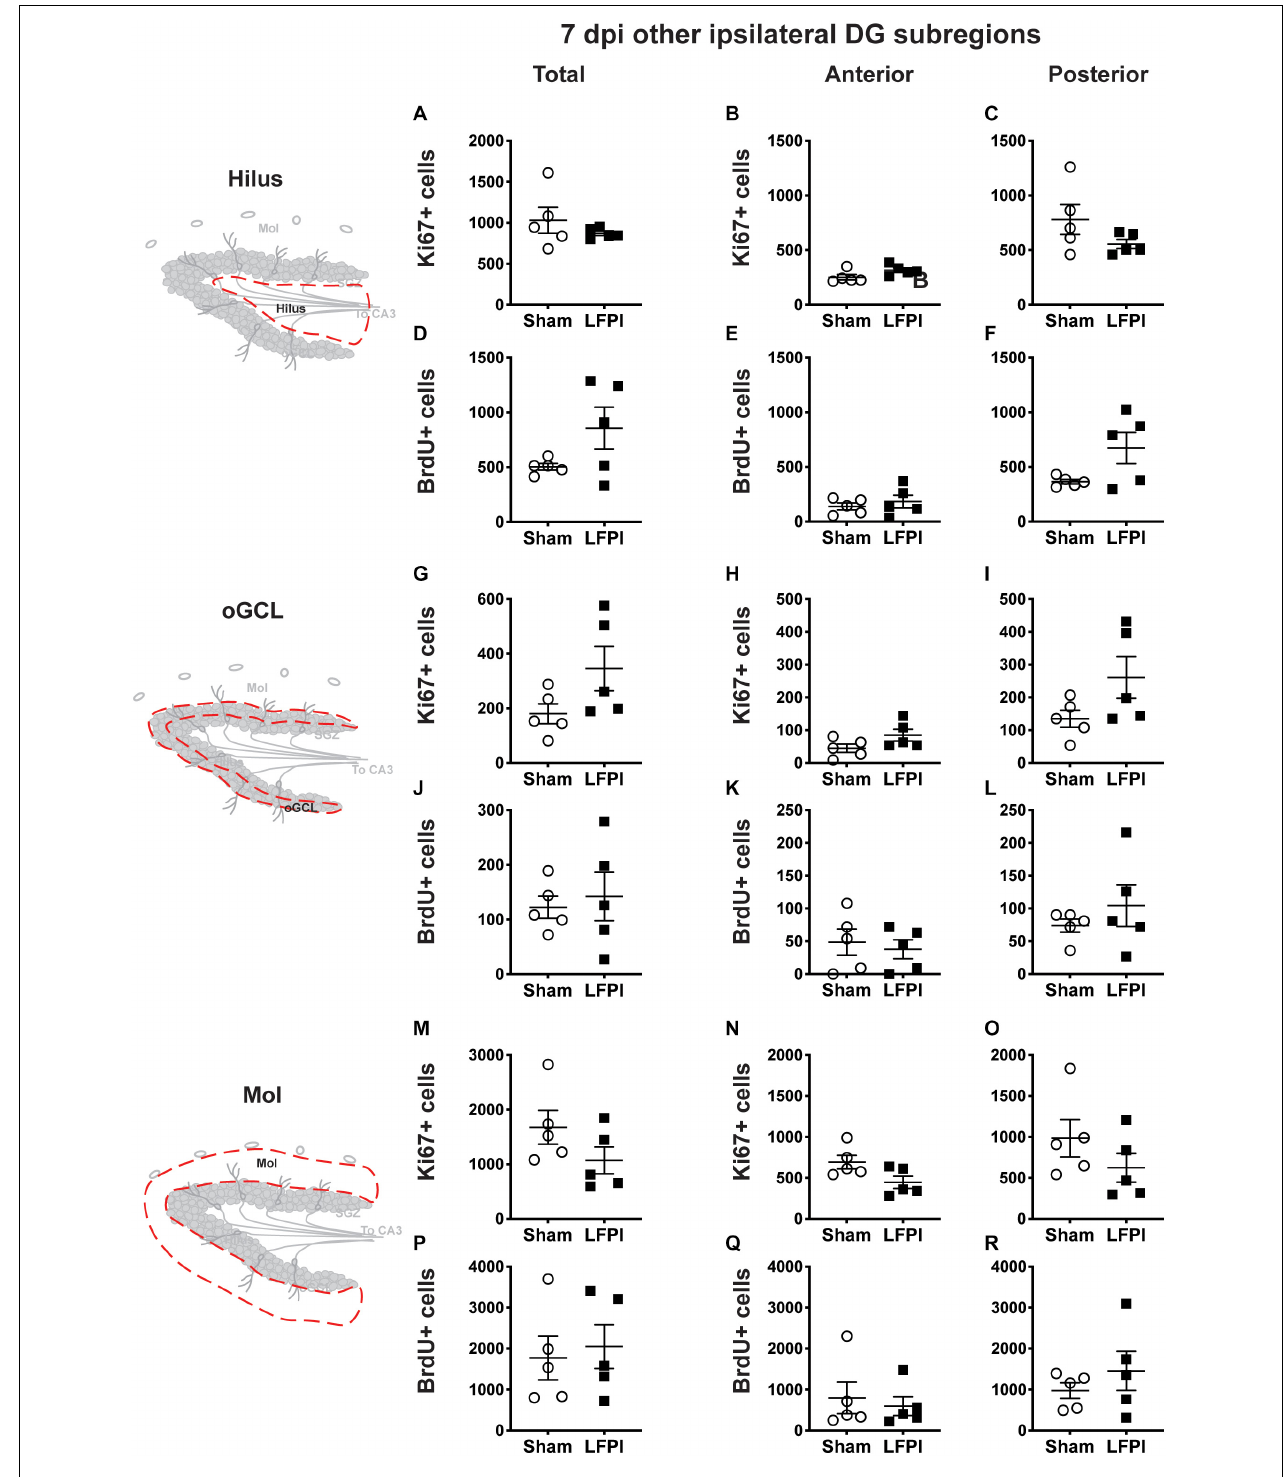
FIGURE 5 | Relative to Sham, LFPI does not change the number of Ki67+ or BrdU+ cells in the ipsilateral DG hilus, oGCL, and Mol 7 dpi. Stereological quantification of Ki67+ ( A–C,G–I,M–O ; Sham n = 5, LFPI n = 5) and BrdU+ (D–F,J–L,P–R ; Sham n = 5, LFPI n = 5 ) cells in the hilus ( A–F ; red dotted line region, top-left schematic), outer granule cell layer ( G–L ; red dotted line region, middle-left schematic), and molecular layer ( M–R ; red dotted line region, bottom-left schematic). Immunopositive cells were quantified across the entire longitudinal axis (A,D,G,J,M,P) , and also broken up into anterior (B,E,H,K,N,Q) , and posterior (C,F,I,L,O,R) bins, operationally defined as Bregma levels − 0.92 to − 2.6; and − 2.6 to − 3.97, respectively.